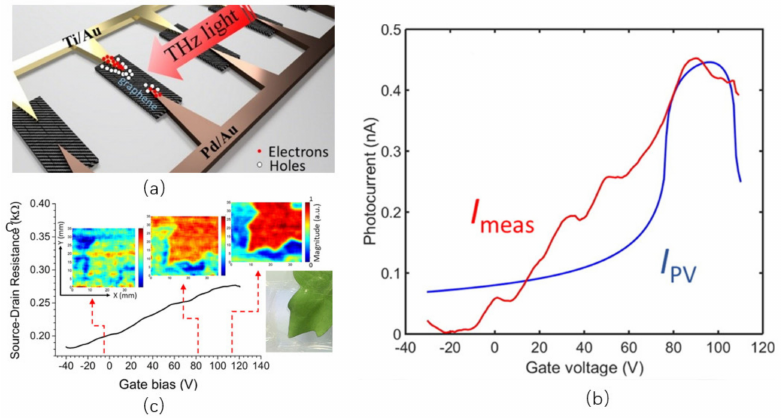
Figure 4. ( a ) Illustration of the photovoltaic-based detector concept map. ( b ) Blue trace I PV is the calculated photovoltaic current, and red trace I meas is the measured photocurrent. ( c ) The THz diagrams of fresh blades under different grid bias voltages. The three photos correspond to the bias voltages of 0, 80, and 110 V respectively. Reprinted with permission from ref. [73]. Copyright 2016 American Chemical